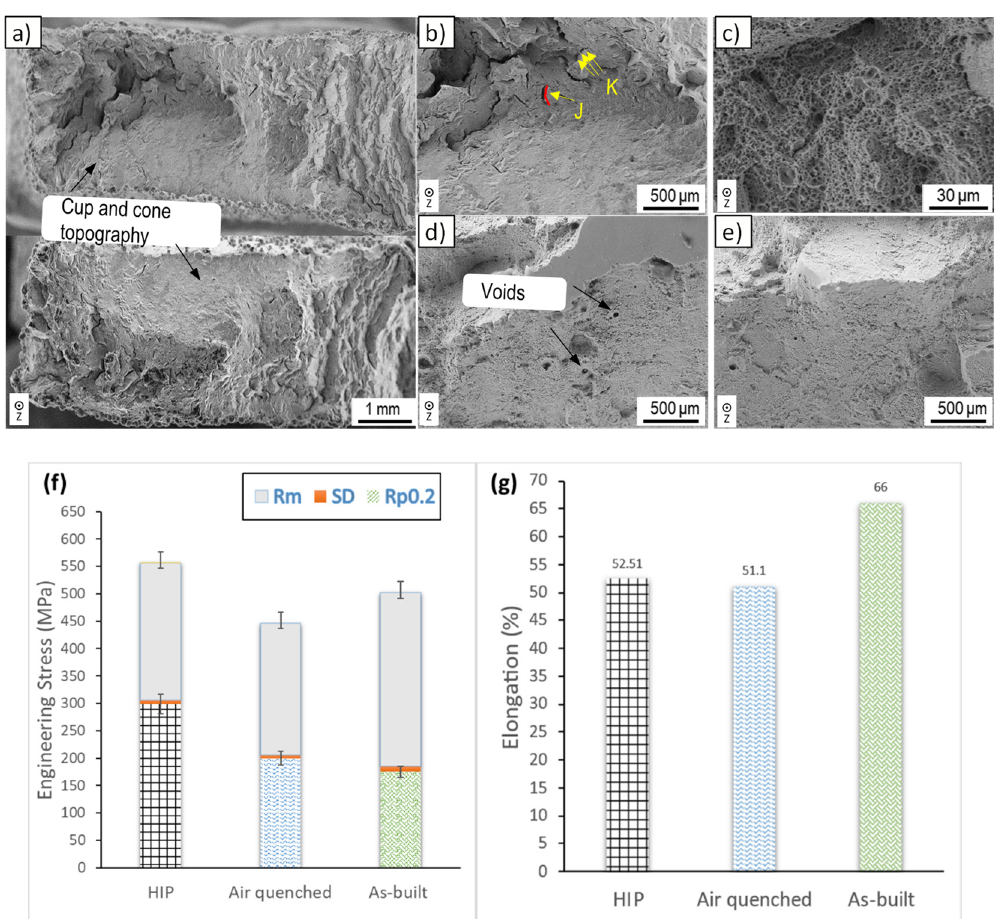
Figure 3. Analysis of mechanical properties. ( a – c ) A representative cup and cone fracture surface of the HIP sample showing clearly the dimples, with (K) aligned microductilities and (J) intergranular cracks; ( d , e ) a representative fracture surface of an air-quench and as-built sample, respectively; ( f , g ) bar charts with the tensile properties for the three sets of samples.